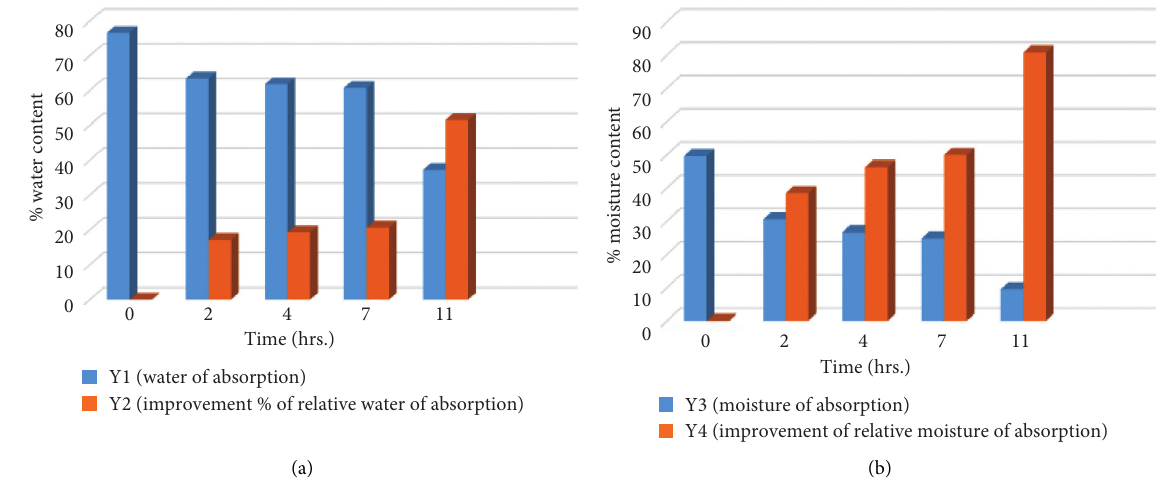
Figure 4: (a) Water absorption/% improvement (water) absorption rates for the treated fibres as a function of treatment length of time. (b) Moisture absorption/% improvement (moisture) absorption rates for the treated fibres as a function of treatment length of